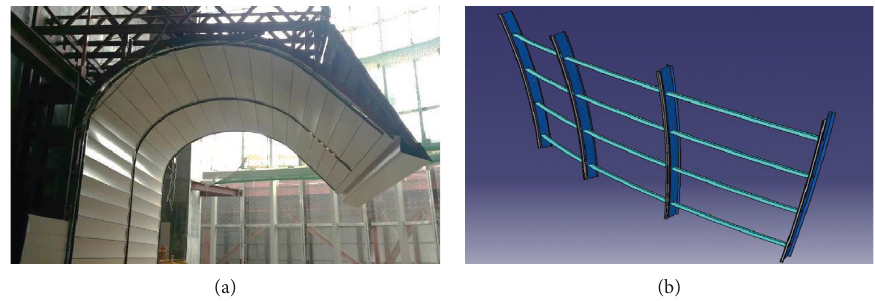
Figure 7: Free-form curved surface (a) and CNC T-BAR system